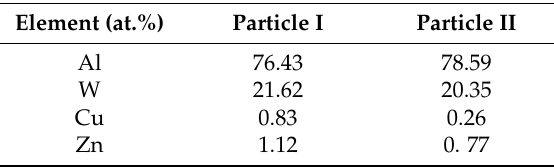
Figure 14. Wear morphology of the aluminum substrate and cladding layers prepared with different powders: ( a ) Substrate; ( b ) 60 wt.% CuZn40 + 40 wt.% WC; ( c ) 40 wt.% CuZn40 + 60 wt.% WC; ( d ) 20 wt.% CuZn40 + 80 wt.% WC. Table 2. The EDS results of particle I and particle II.